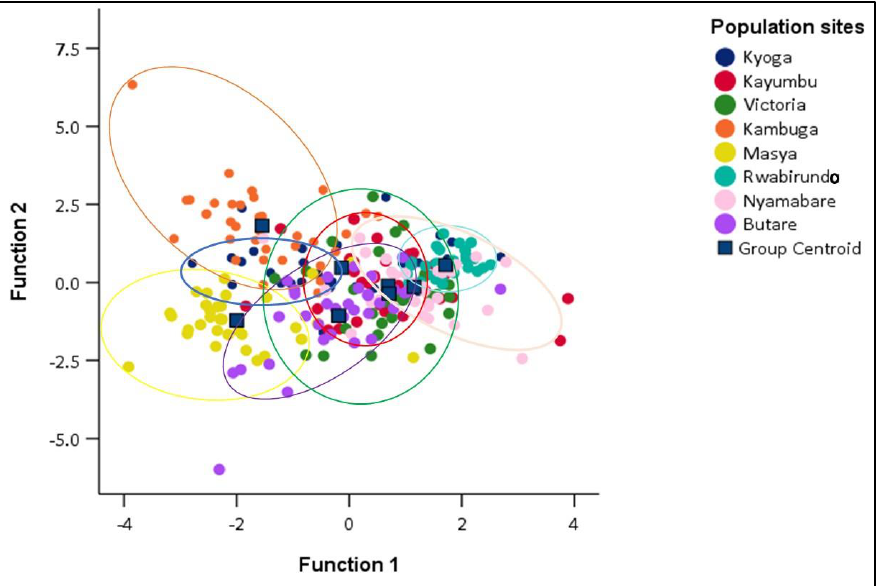
Figure 5. Canonical Discriminant Functions for different populations. Table 4. Classification Results for all the populations. The overall random assignment of individuals into their original group was 65.5% (Table 4) with Victoria and Rwabirundo having a higher correct classification 90.6 and 90.0%, respectively, while Kayumbu had the least classification (43.8%) (Table 4). The proportion of individuals correctly classified into their original group, i.e., Kyoga,